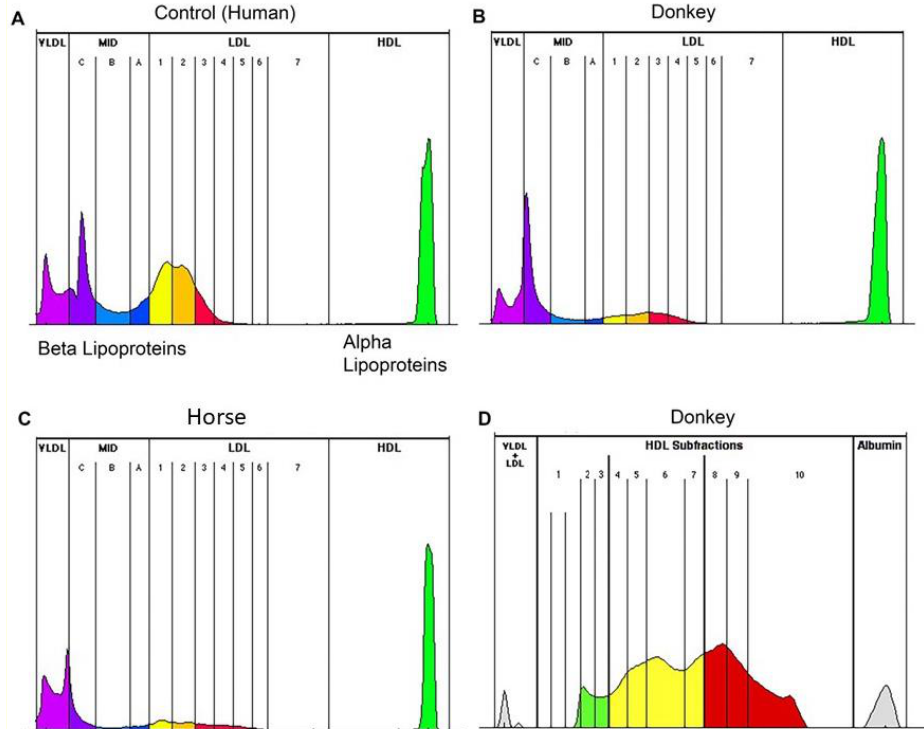
Figure 1. Representative lipoprotein plots from ( A ) human plasma control sample, ( B ) donkey, horse, ( C ) showing peaks for VLDL (light purple), midfractions (dark purple and light blue), LDL (yellow, orange, and red), and HDL (green), ( D ) depicting a representative HDL subfractionation from a donkey sample. HDL are divided into large particles (green), intermediated sized particles (yellow) and small sized HDL (red). Numbers indicate the subfraction.